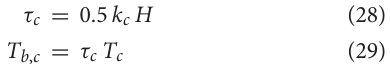
Frontiers in Astronomy and Space Sciences |